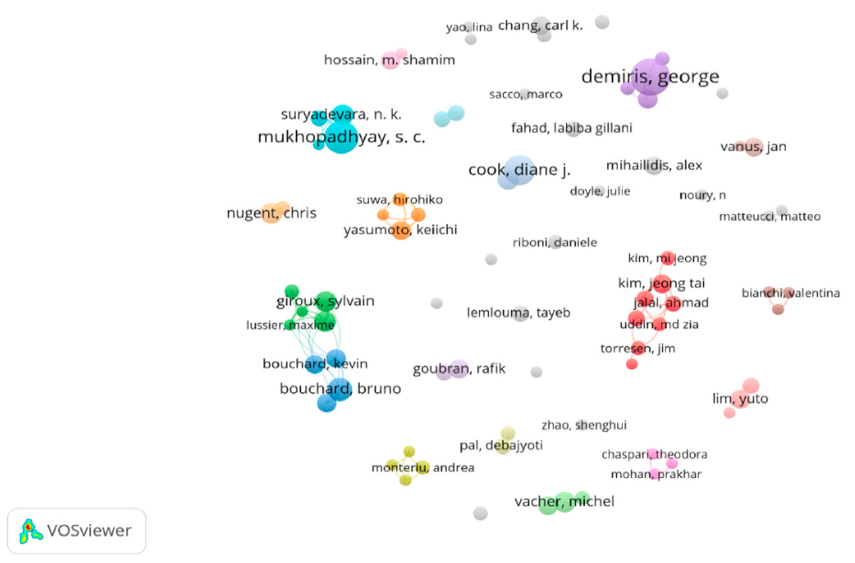
Figure 4. Network visualization by main authors.